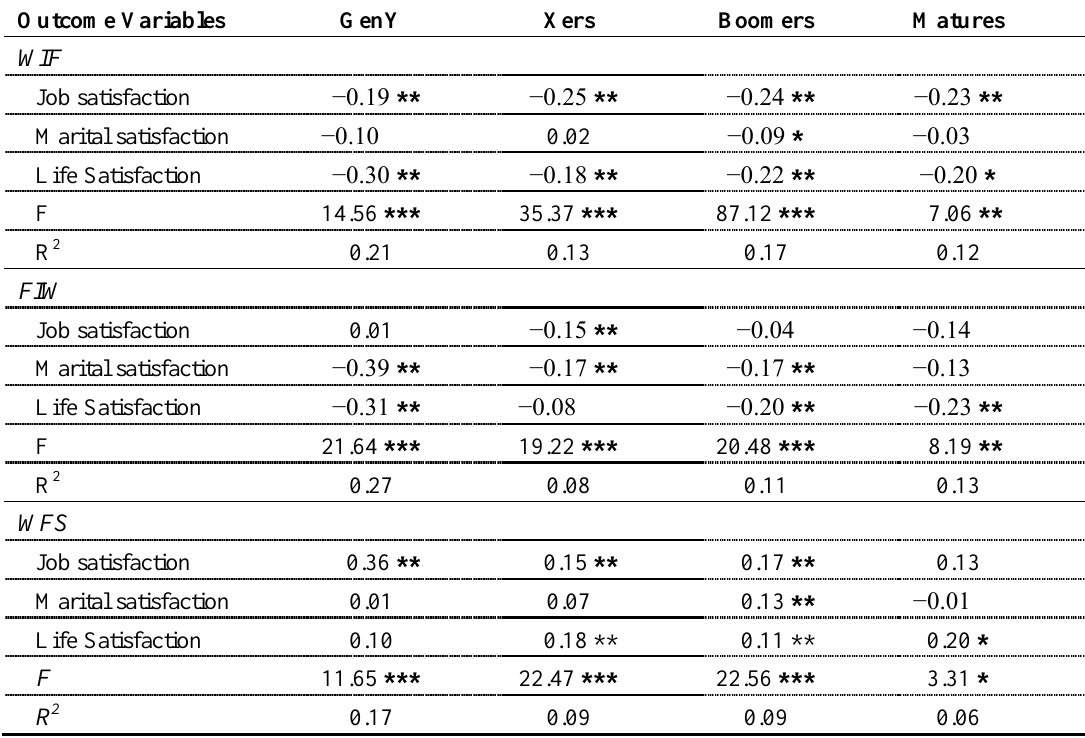
Table 6. Regressions for work-family conflict and synergy on satisfaction outcomes by generational